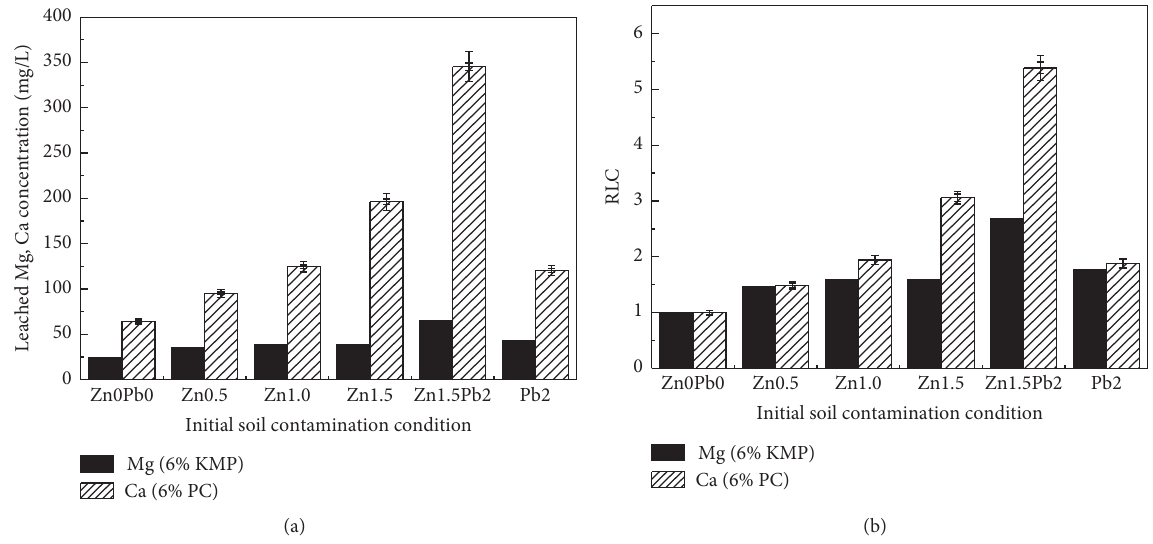
Figure 3: Leached amount of Mg and Ca obtained from the acid neutralization test (ANC) for the stabilized soils cured for 28d: (a) leached Mg and Ca concentrations and (b) ratio of leached Mg or Ca concentration (RLC) for the contaminated soil to that for the clean